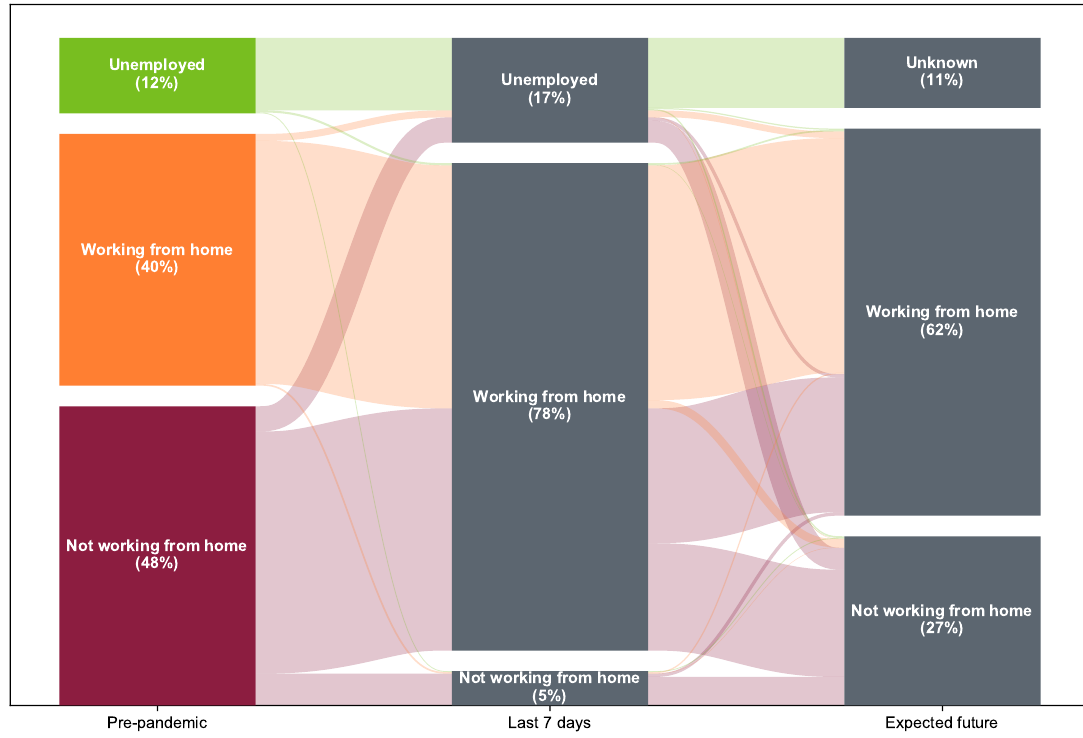
Figure 3. Trends in working from home at least a few times a month before, during, and after the pandemic ( n =